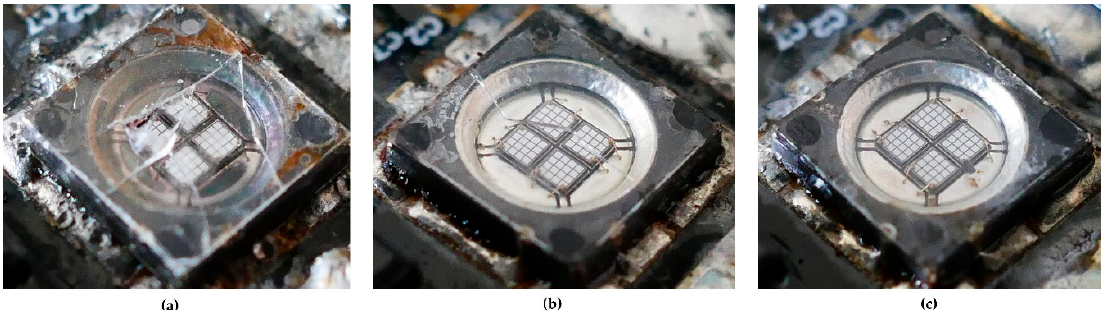
Figure 13. Spectral LED radiance, normalized to the maximum of each LED, before (blue) and after